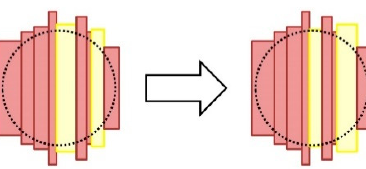
Figure 3. Procedure for applying the internal crossing operator to a head: two randomly chosen staves of the original head (represented in yellow) change their positions in the head if the new distribution of the staves complies the size requirements of the barrel head.